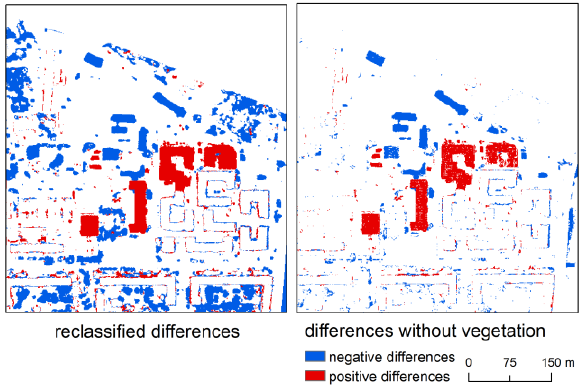
Figure 6. Comparison of reclassified differences (changes) before and after vegetation exclusion After removing the vegetation, final changes were obtained. In Figure 7, detected changes from dDSMs from different pyramid levels are provided. According to Figure 7, for levels 0 and 1, the changes are still very detailed, and most of them are irrelevant, even after removing changes of area smaller than 25 m 2 . For levels 3 and 4, there is a risk that the areas of the detected buildings are too big. Thus, level 2 of the pyramid seems to be the most appropriate concerning building change detection from DSMs from aerial images.